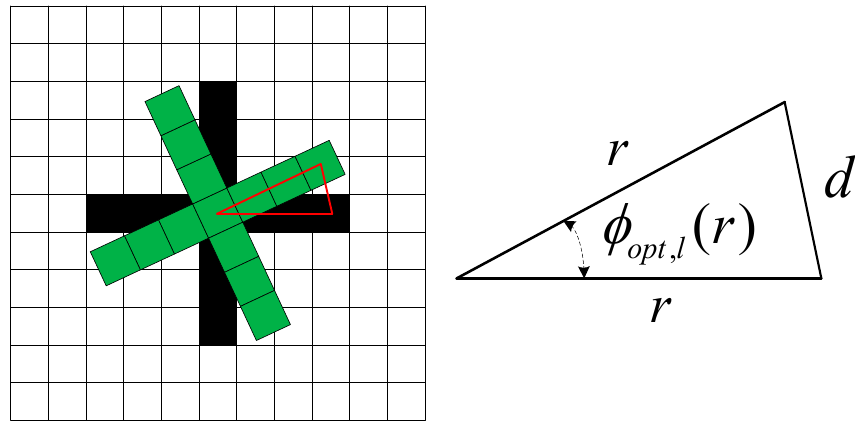
Figure 6. Definition of the optimal step angle for image pyramid level l .